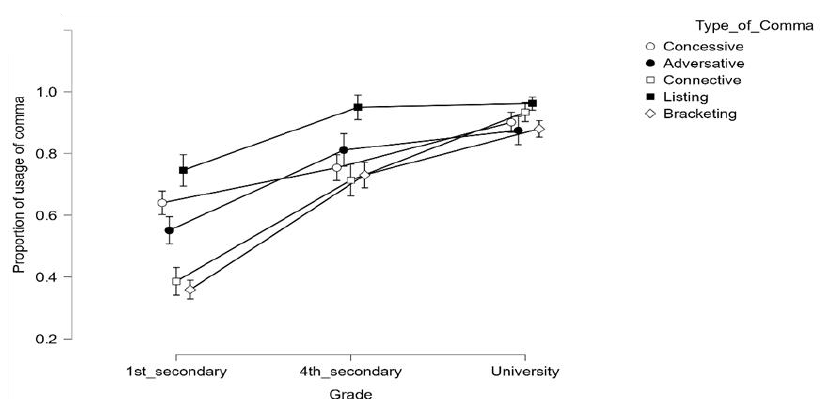
Figure 1. The proportion of use of the various types of commas in first-year students of secondary education, fourth-year students of secondary education, and first-year university students. For each condition, the bars represent the 95% confidence intervals.